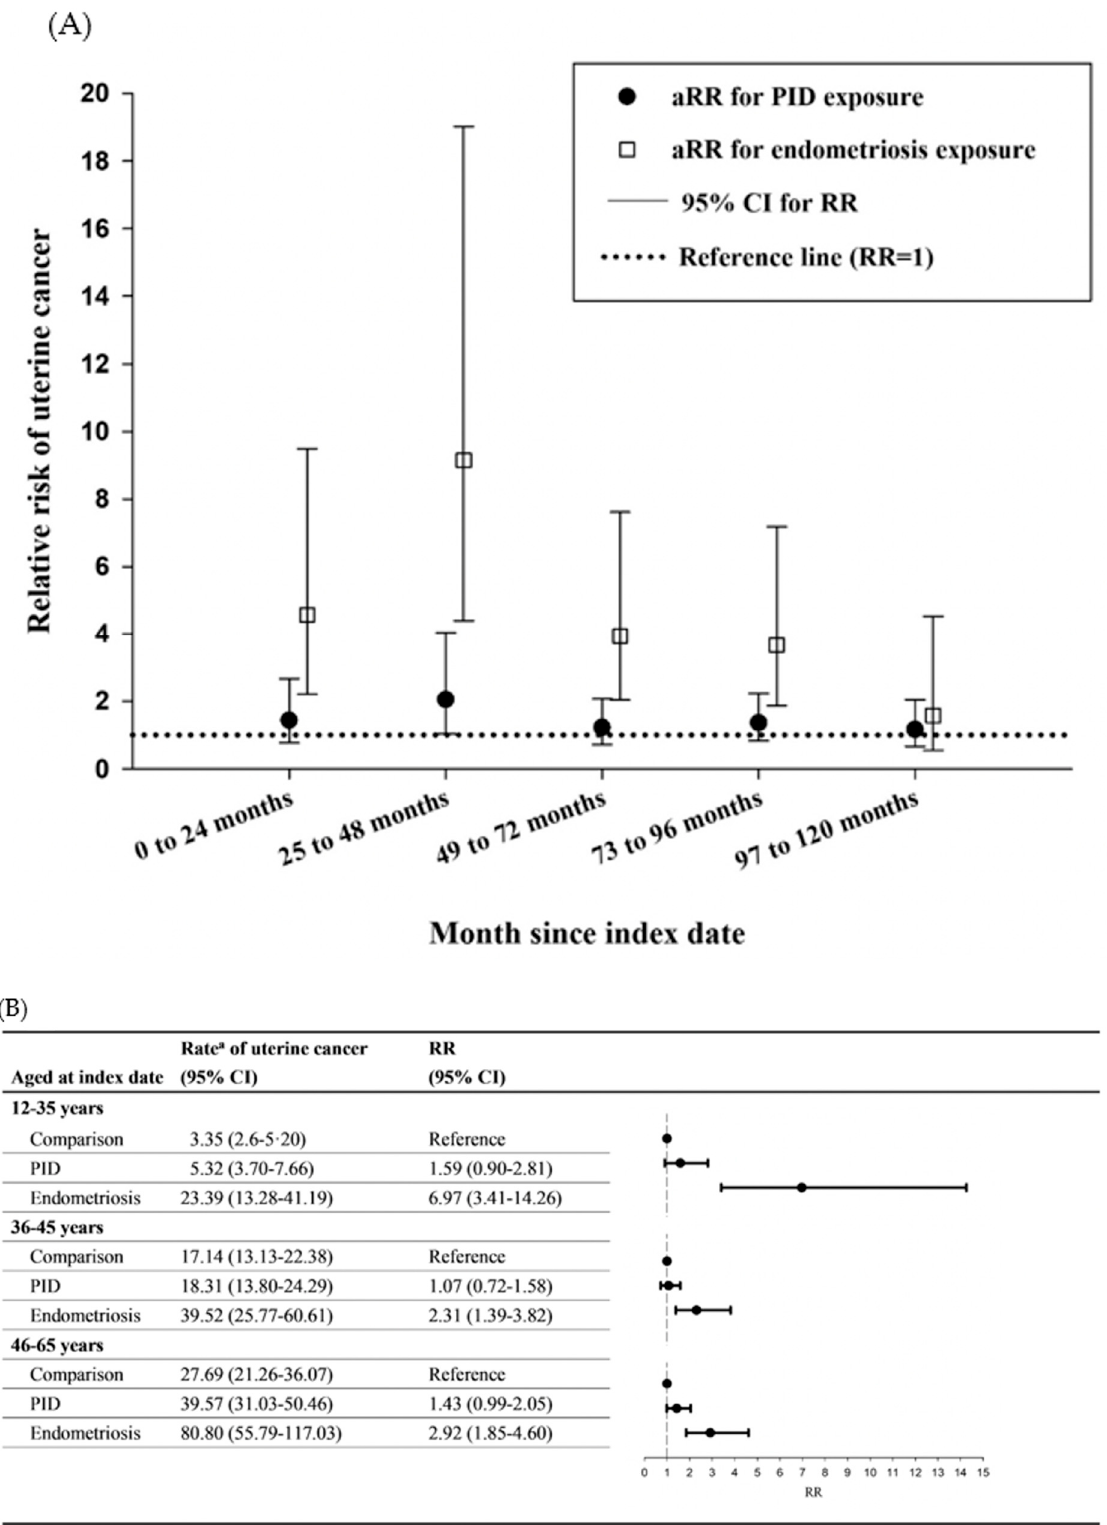
Figure 2. Age-dependent and time-varying effect of endometriosis on uterine corpus cancer. ( A ) Subgroup analysis for uterine corpus cancer among age and birth year matched population. ( B ) Landmark analysis for time varying effect on the risk of uterine corpus cancer. a Crude rate, per 100,000 person-years. PID, pelvic inflammatory disease; RR, relative risk; 95% CI, 95% confidence interval. aRR, adjusted relative risk.